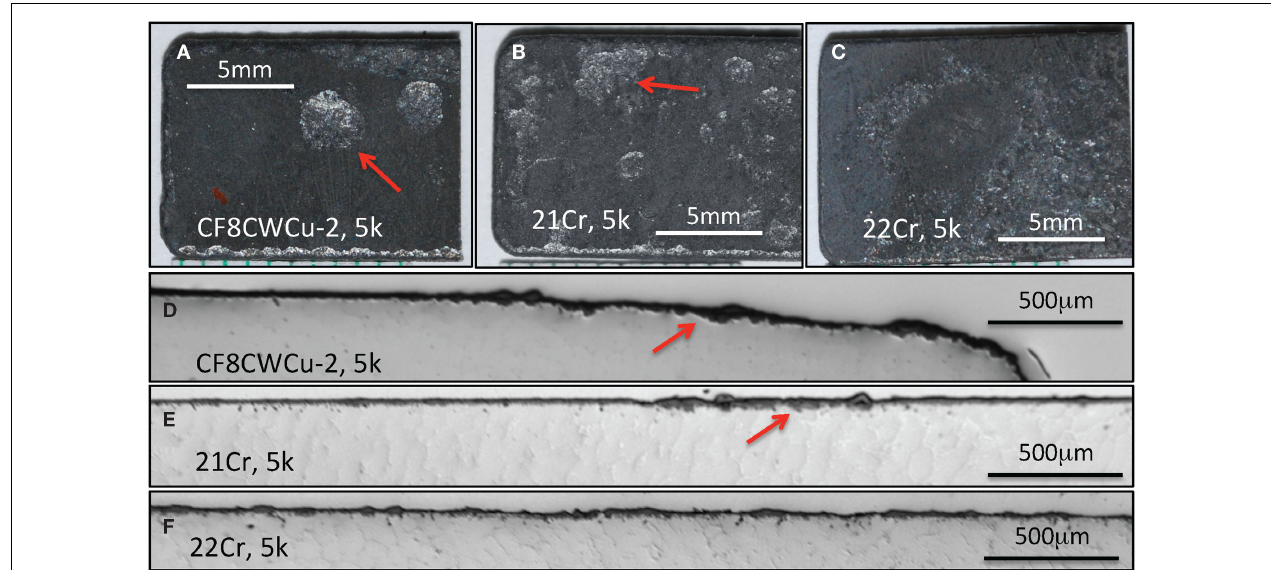
FIGURE 10 | Optical images of specimens exposed for 5000h at 800°C in air +++ H 2 O, (A) top view, alloy CF8CWCu-2, (B) top view, alloy 21Cr, (C) top view, alloy 22Cr, (D) Cross-section, alloy